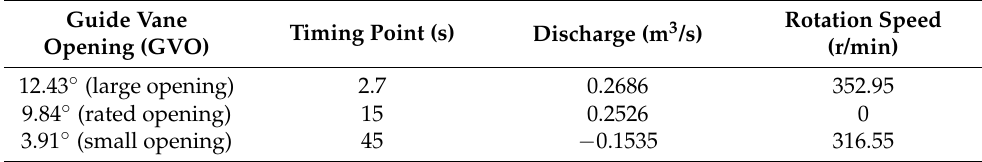
Figure 5. Responses of the HGS during load-reduction process. Table 2. HGS values under typical guide vane openings.